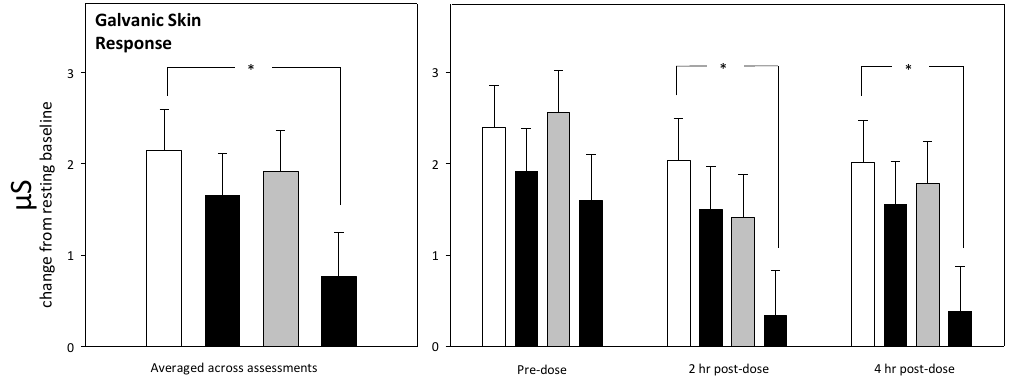
Figure 8. Chronic (Day 29) treatment-related change in the electrodermal galvanic skin response to the stressor. Data are change from resting baseline estimated means (plus SE) derived from the LMM analysis, using pretreatment (Day 1 pre-dose assessment) data and age as covariates. The left-hand panel shows planned comparisons between group means averaged across the testing day, and the right panel shows planned comparisons during each individual assessment. *, p < 0.05 in comparison to placebo.